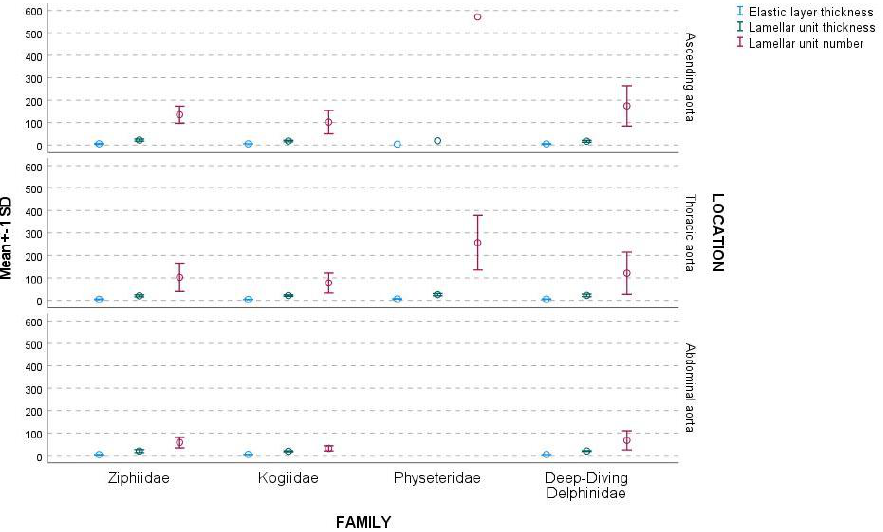
Figure 8. Representation of the mean ± SD (μm) of the elastic and lamellar unit thickness and the number of lamellar units by aortic location and family.